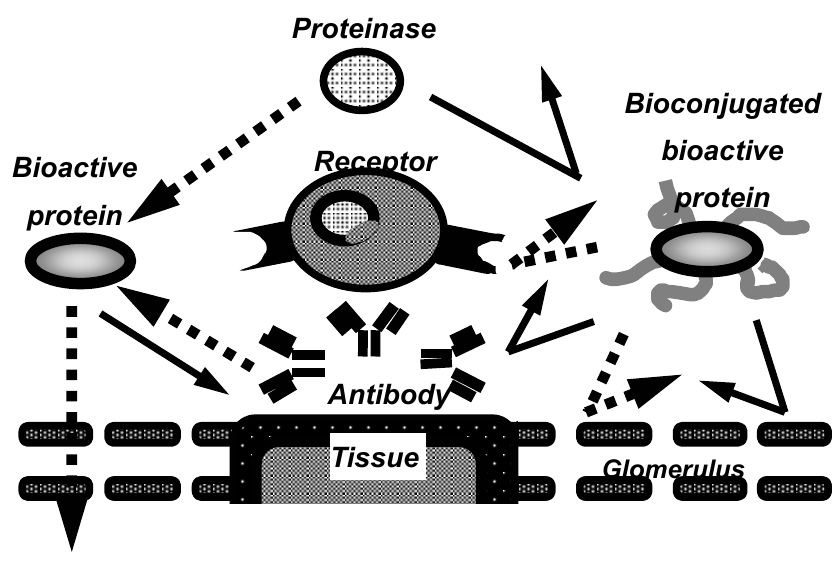
Figure 1. Characteristics of bioconjugated